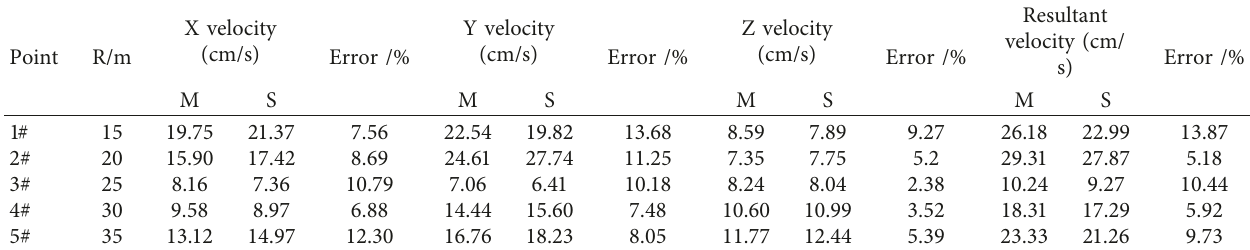
Figure 5: The specific layout of measurement points. Table 4: Comparison of simulated and measured values of peak particle velocity (with in situ stress).